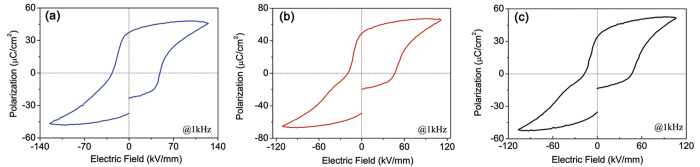
P-E hysteresis loops of Bi1-δFe0.95Mn0.05O3 films with increasing Bi deficiency contents measured at 1 kHz.(a) δ = 0.005, (b) δ = 0.028, and (c) δ = 0.034.